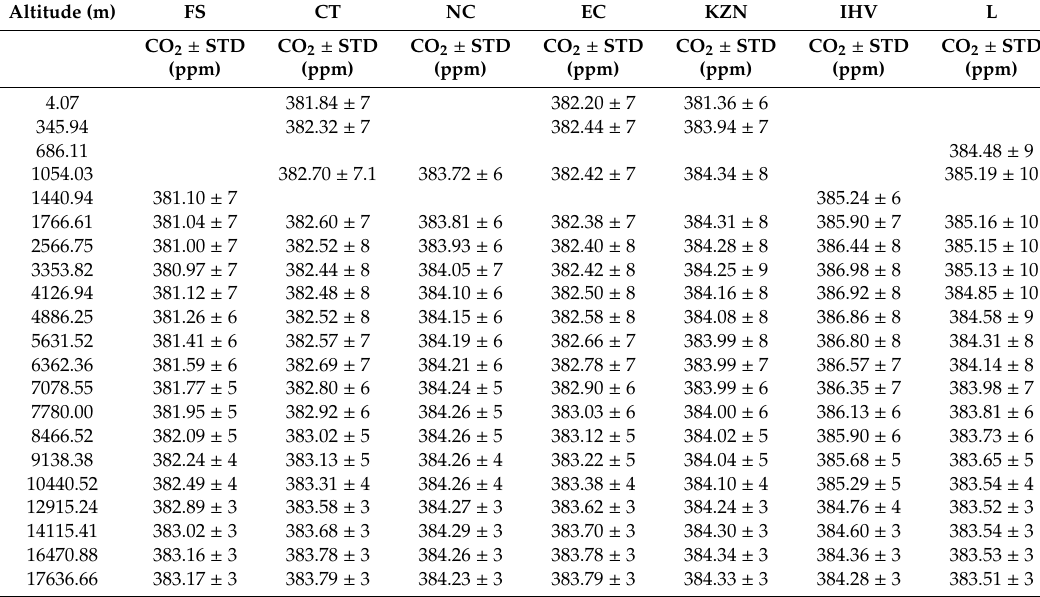
Table A2. Autumn (MAM) horizontally averaged CO 2 data and the associated standard deviations at di ff erent altitudes used for vertical profiles at the di ff erent study areas. Altitude (m)